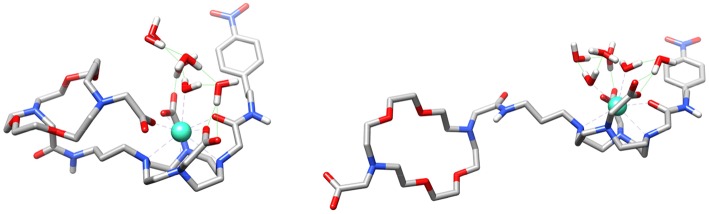
Structures of the GdL3(H2O)2·4H2O system obtained with DFT calculations showing the coordination of the carboxylate group of the crown moiety to the metal ion (left) and the open form (right).